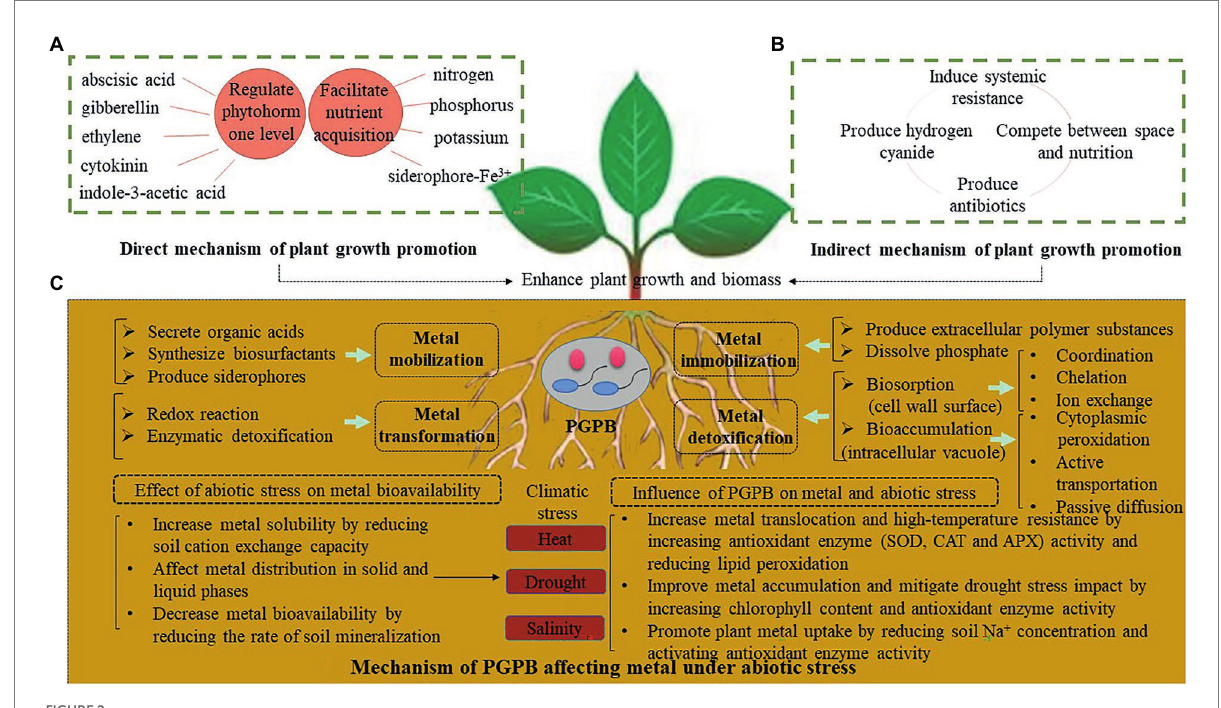
FIGURE 2 Mechanism of the synergistic effects of PGPB on the bioremediation of metal-contaminated soils. (A) Direct mechanism of plant growth promotion; (B) Indirect mechanism of plant growth promotion; (C) Mechanism of PGPB affecting metal under abiotic